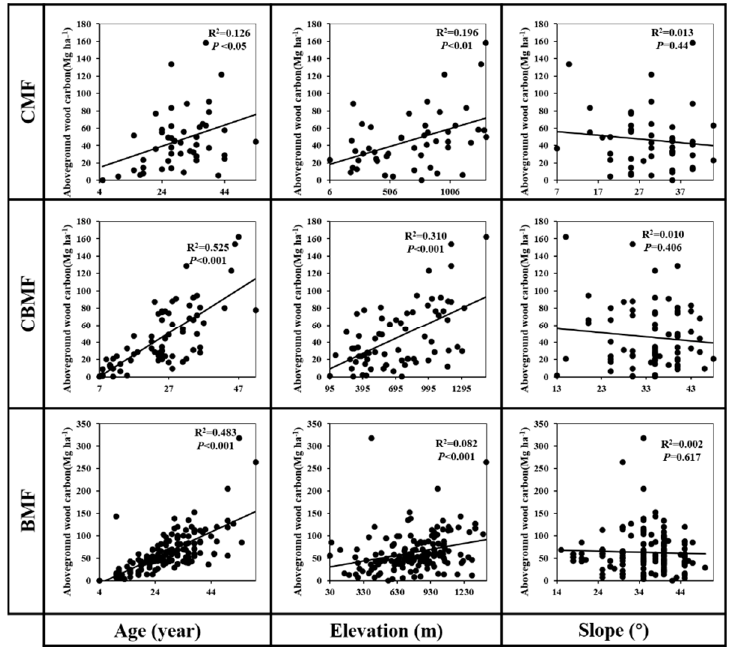
Figure 5. Bivariate relationships between abiotic variables and aboveground wood carbon. CMF, CBMF, and BMF represent coniferous mixed forests, coniferous–broadleaf mixed forests, and broadleaf mixed forests, respectively.